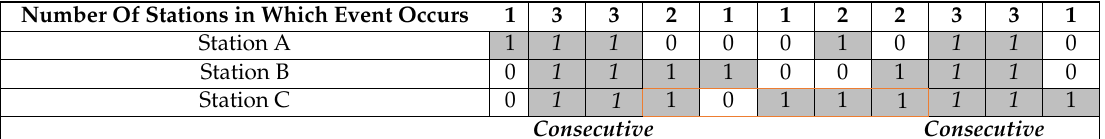
Table 1. Example of short time series resulting from occurrence model for a three stations case. Number Of Stations in Which Event